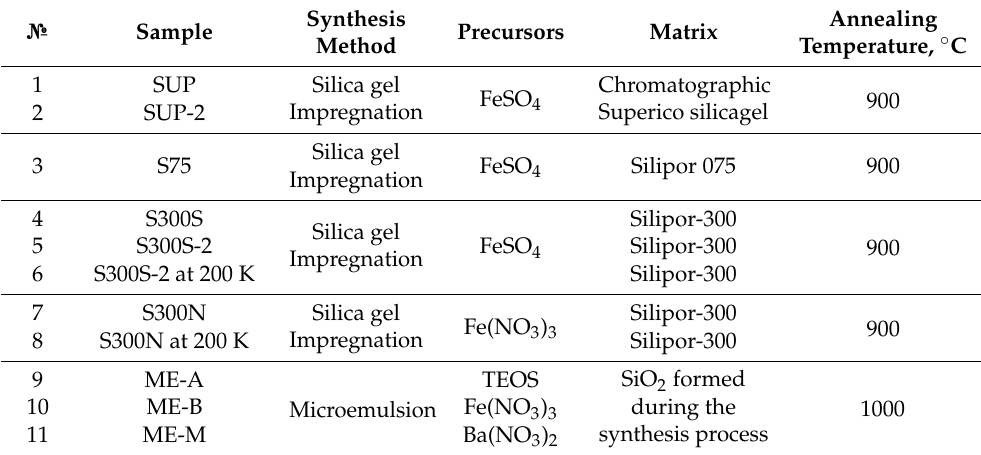
Table 2. Synthesis parameters of all